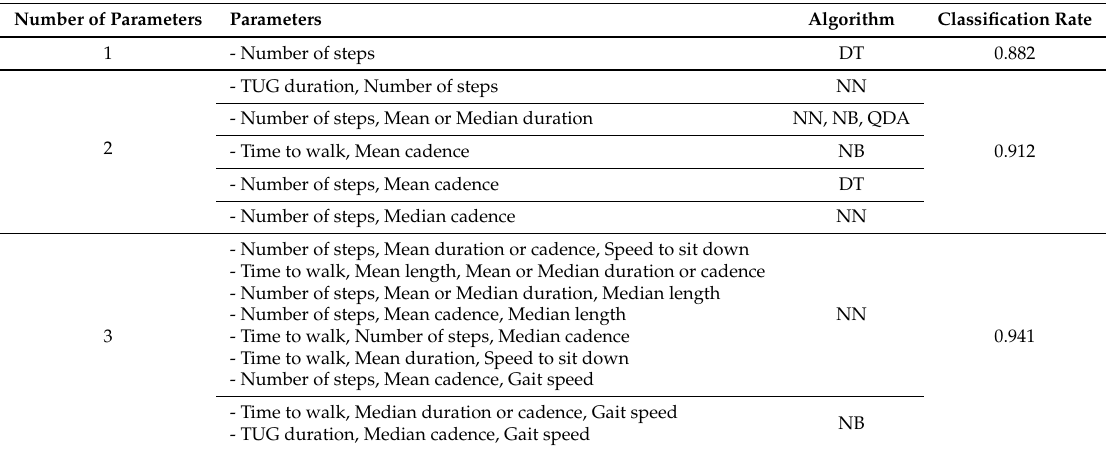
Table 5. Best parameter combinations for the three classes problem. The best classification score is presented in fourth column. A score of 1 would be a perfect score, i.e., without any classification error. The third column indicates the algorithm giving the best result (NN = Neural Net, NB = Naive Bayes, DT = Decision Tree, QDA = Quadratic Discriminant